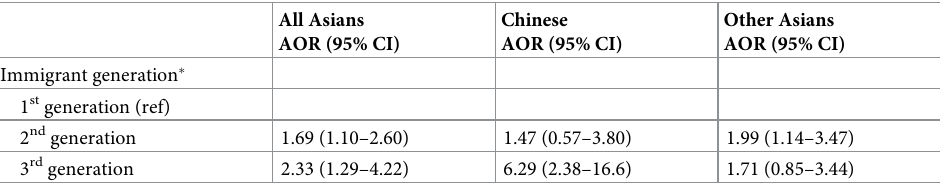
Table 3. Multiple logistic regression analyses for the association between immigrant generation and obesity among Asian Americans, CHIS